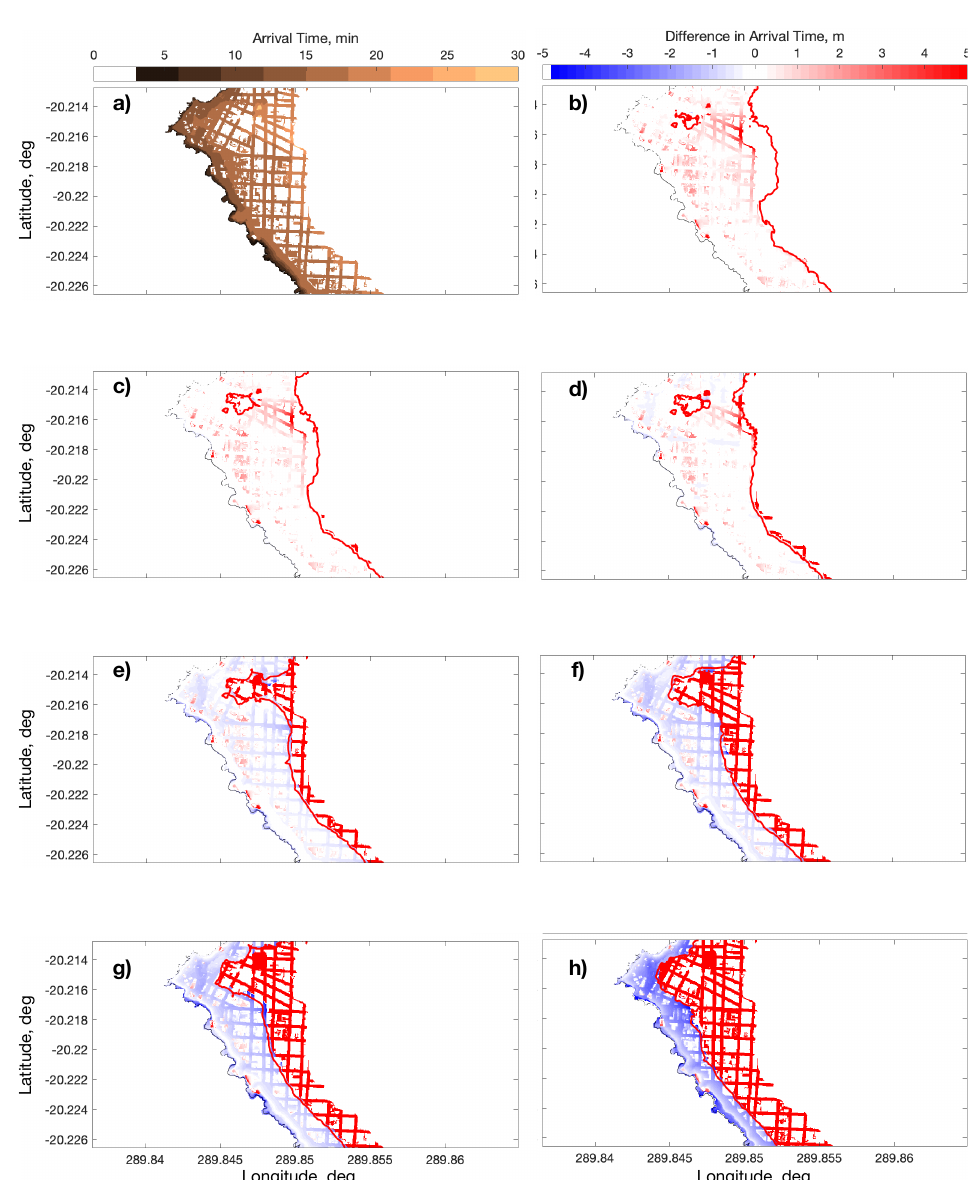
Figure 3. Arrival time comparison between the DSM model, including resistant buildings, and a DTM model, on Grid-L3b. ( a ) Arrival time of the reference, DSM model; ( b – h ) Difference in arrival time between DSM and DTM-CRM, with maximum grid resolution, R 1 . ( b ) n = 0.025; ( c ) n = 0.04; ( d ) n = 0.06; ( e ) n = 0.10; ( f ) n = 0.15; ( g ) n = 0.20; ( h ) n = 0.40. The red line denotes the inland limit